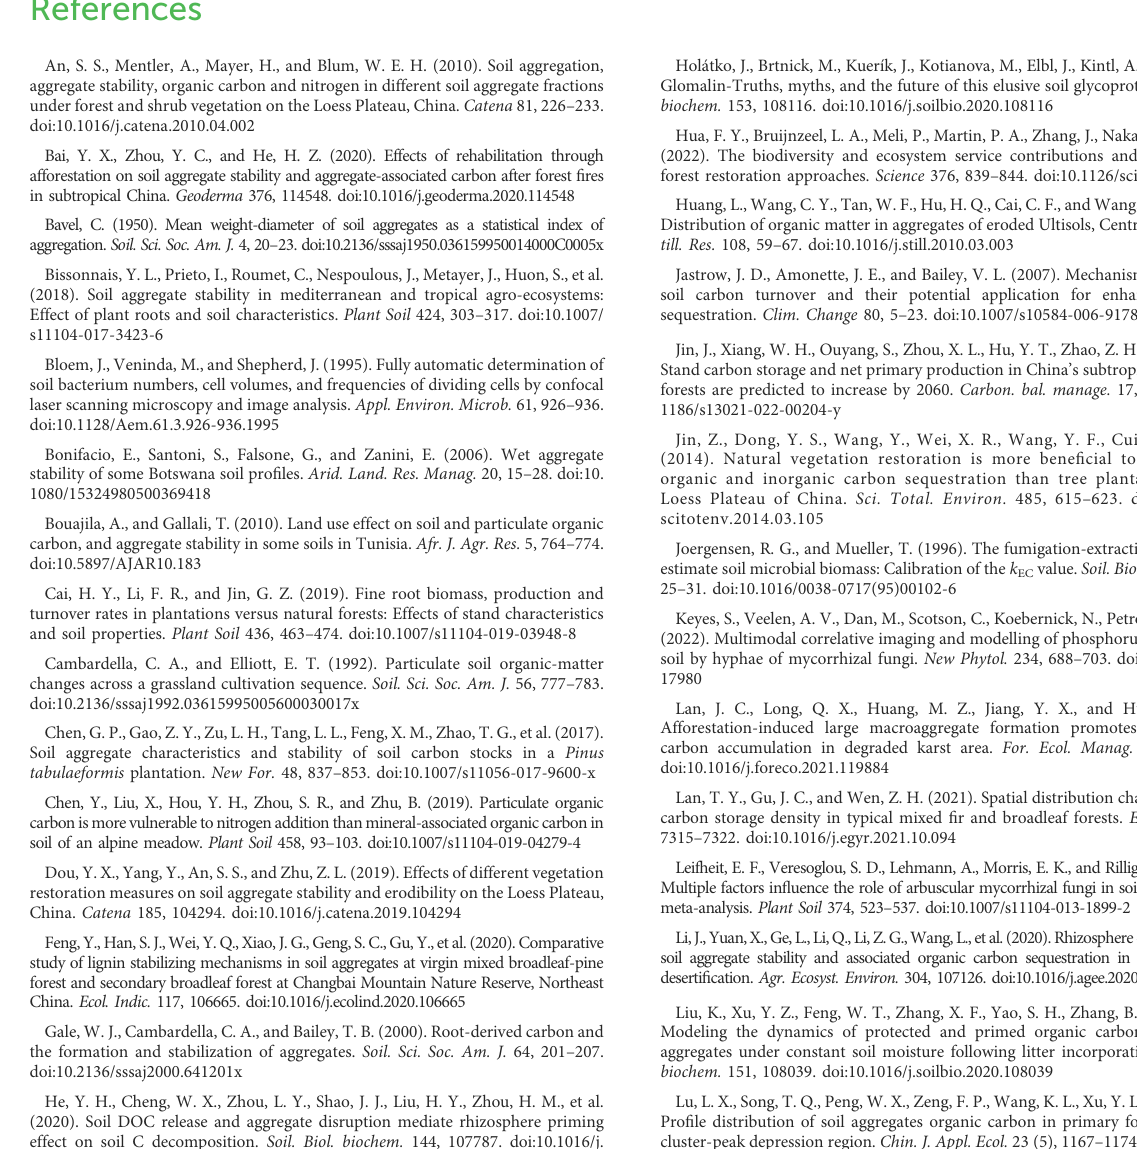
SUPPLEMENTARY FIGURE S1 Model-averaged importance of the predictors of MWD. The importance is based on the sum of Akaike weights derived from model selection using the corrected AIC. Cutoff is set at 0.8 (red dashed line) to differentiate among the most important